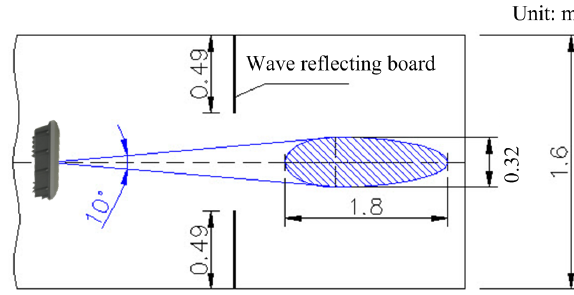
Figure 5. Projection range of the radar waves (tilt angle = 30° and yaw angle = 0°).